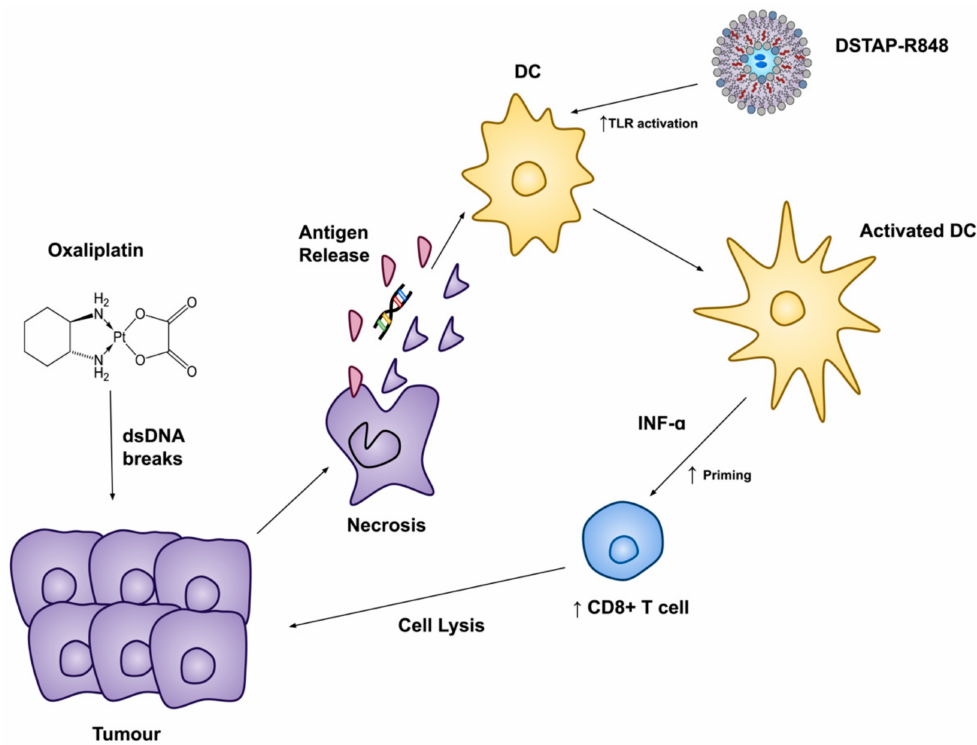
Figure 6. Proposed mechanism of the combination of oxaliplatin and DSTAP-R848.